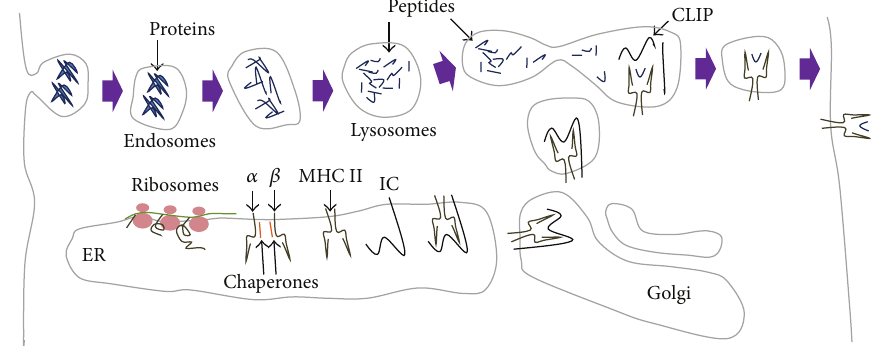
Figure 2: MHC II antigen presentation pathway. MHC II is synthesized in the endoplasmic reticulum (ER) as a heterodimer ( 𝛼 , 𝛽 ). MHC II proteins are also bound to the invariant chain protein (IC), which inhibits the binding of peptides to the MHC II proteins. IC is cleaved after the exocytic vesicles fuse with the acidic lysosomes to form class II invariant chain protein (CLIP). These MHC II proteins bind to small peptides (10–30 a.a.) in the vesicle and appear on the cell surface when these vesicles fuse with the plasma